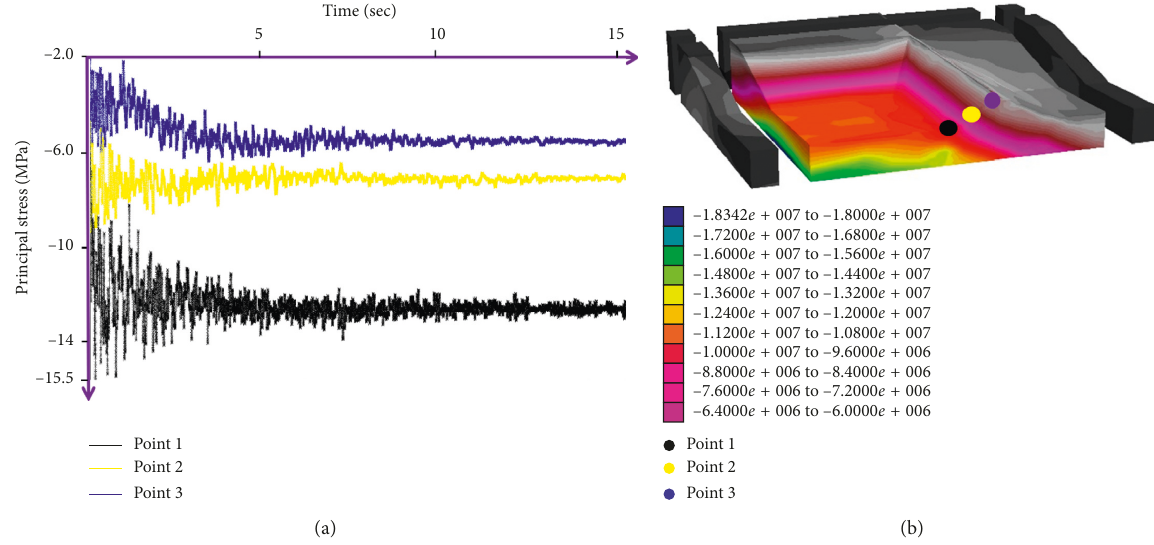
Figure 17: (a) Principal stress-time graphic for the California earthquake. (b) Contour plot diagram for 15 th second of the California